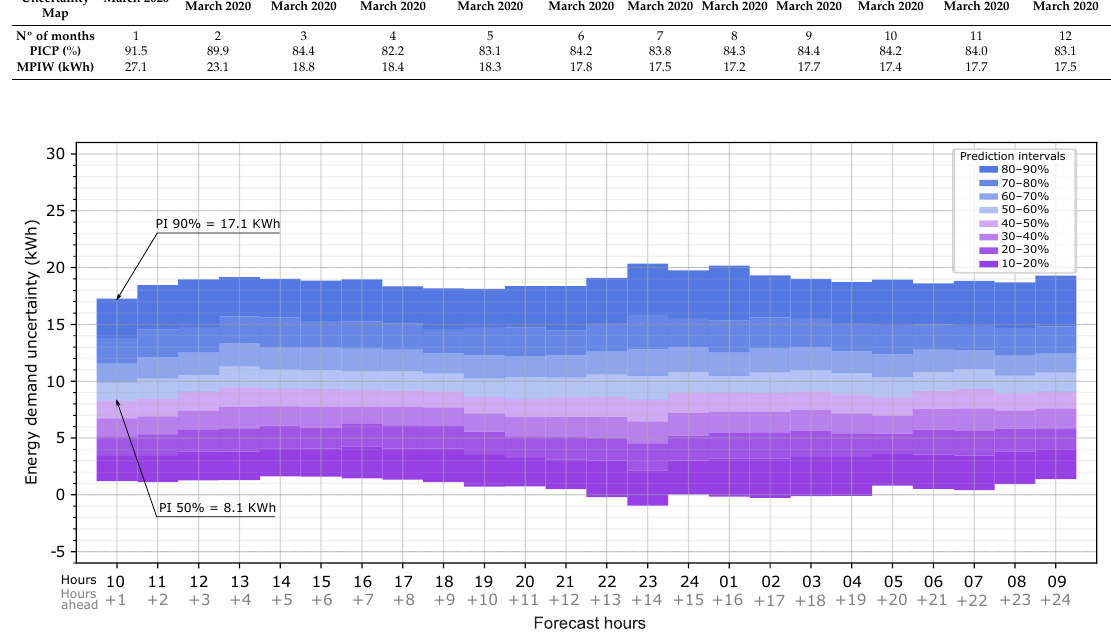
Figure 8. Probabilistic heating load forecast results: Hourly uncertainty map of the heating load forecast due to weather forecast data for the first 24 h ahead of the forecast hour (09:00